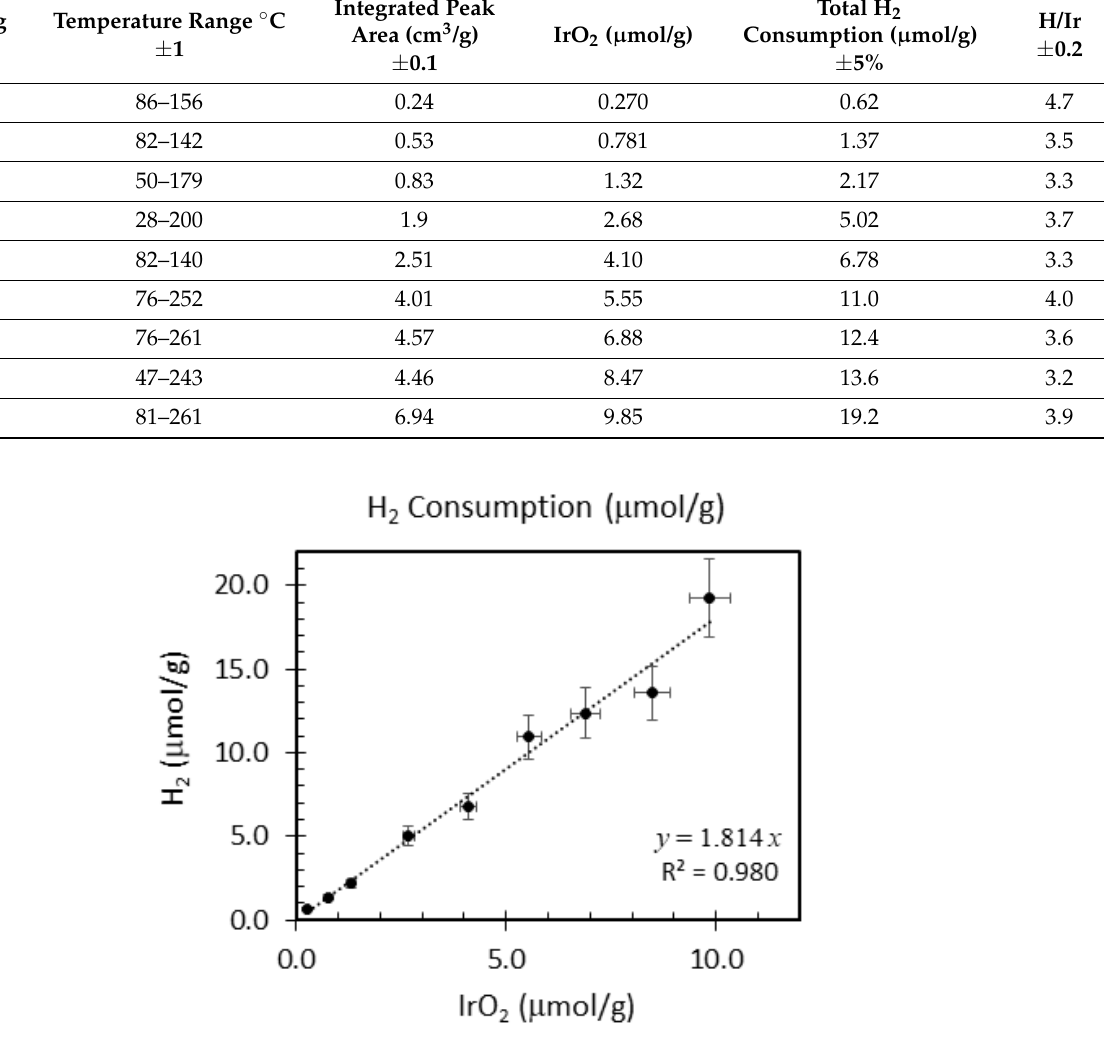
Table 1. Extracted quantitative data from TPR of the series of IrO 2 /TiO 2 (anatase, BET surface area = 55 m 2 /g) catalysts as a function of IrO 2 content with a ramping rate β = 10 °C/min. Ir wt.%